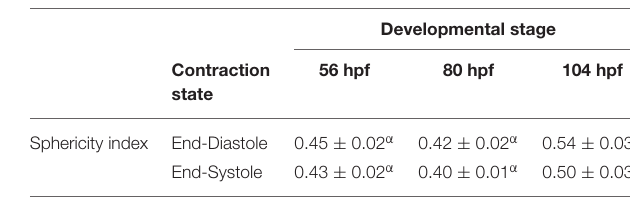
TABLE 1 | Sphericity index of the ventricle during diastolic and systolic events through three post-embryonic stages in